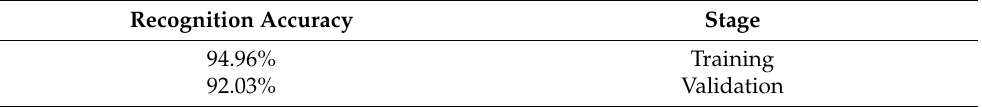
Table 1. Recognition accuracy after model